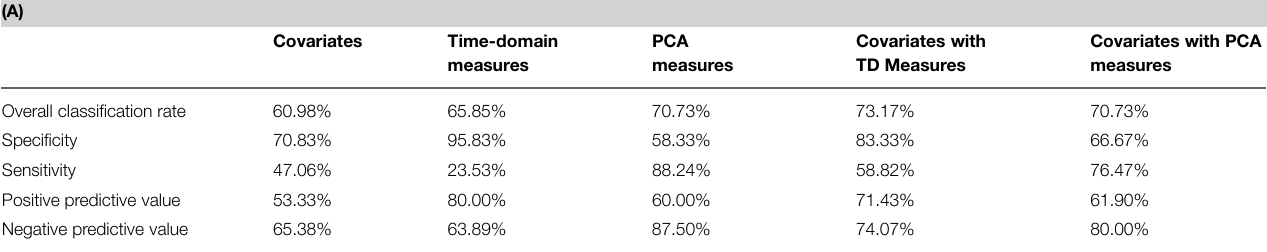
TABLE 8 | Support vector machine analyses with ERP, fMRI, and covariates predicting